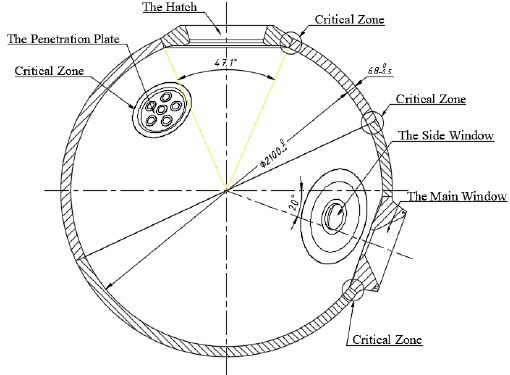
Figure 1. A sketch of spherical pressure hull with critical zones that cracks tend to